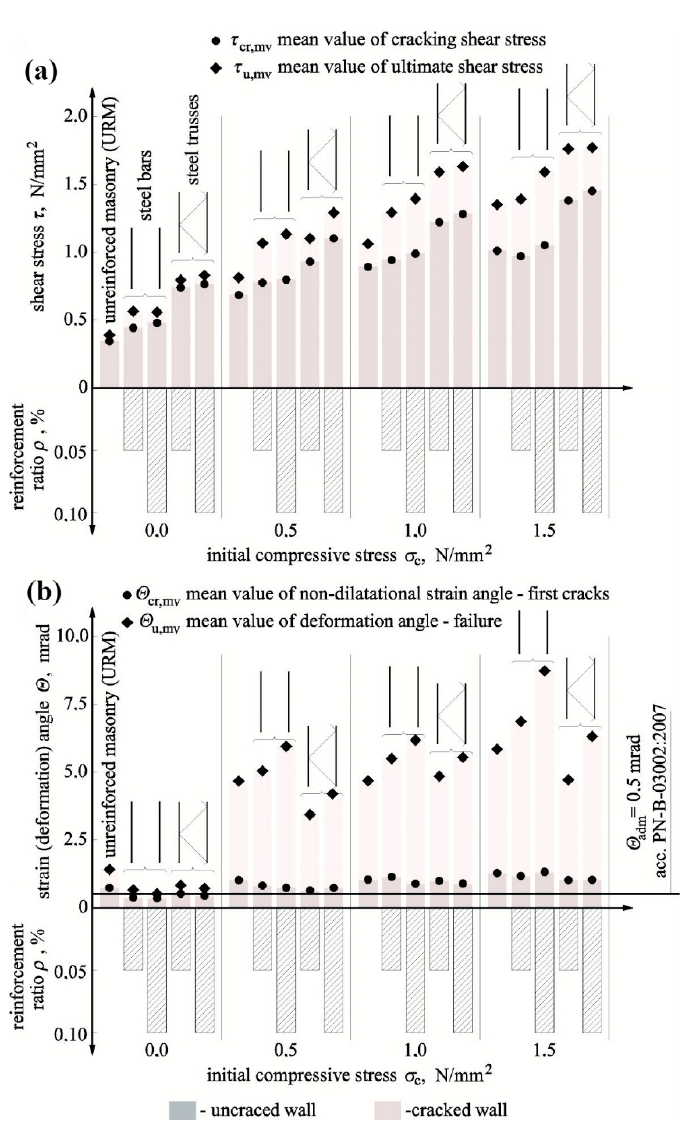
Figure 11. Comparison of test results: ( a ) shear stress at the time of cracking and failure and ( b ) shear–strain angle at the time of cracking and shear deformation angle at the time of failure.